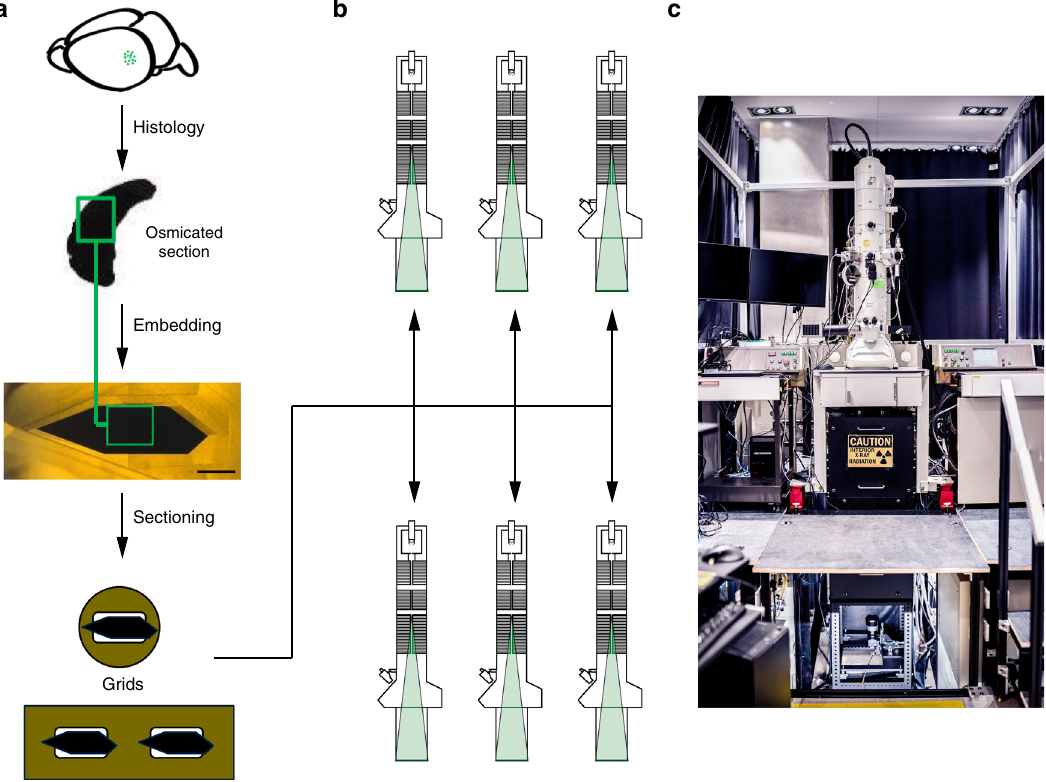
Fig. 1 Experimental pipeline from sample preparation to imaging. a Sample preparation. A mouse brain with the region of interest (ROI) indicated with green dots is sliced into thick brain sections (thickness ≥ 1 mm). The thick brain sections undergo histology with osmium protocol and become dark (the green square represents the ROI to be imaged with the electron microscope). After embedding, the block of tissue (1 mm scale bar) is trimmed in a hexagonal shape and prepared for ultrathin sectioning onto grids or GridTape. b Schematic cross-section of six distributed autoTEMs. c Photograph of an autoTEM system in the EM